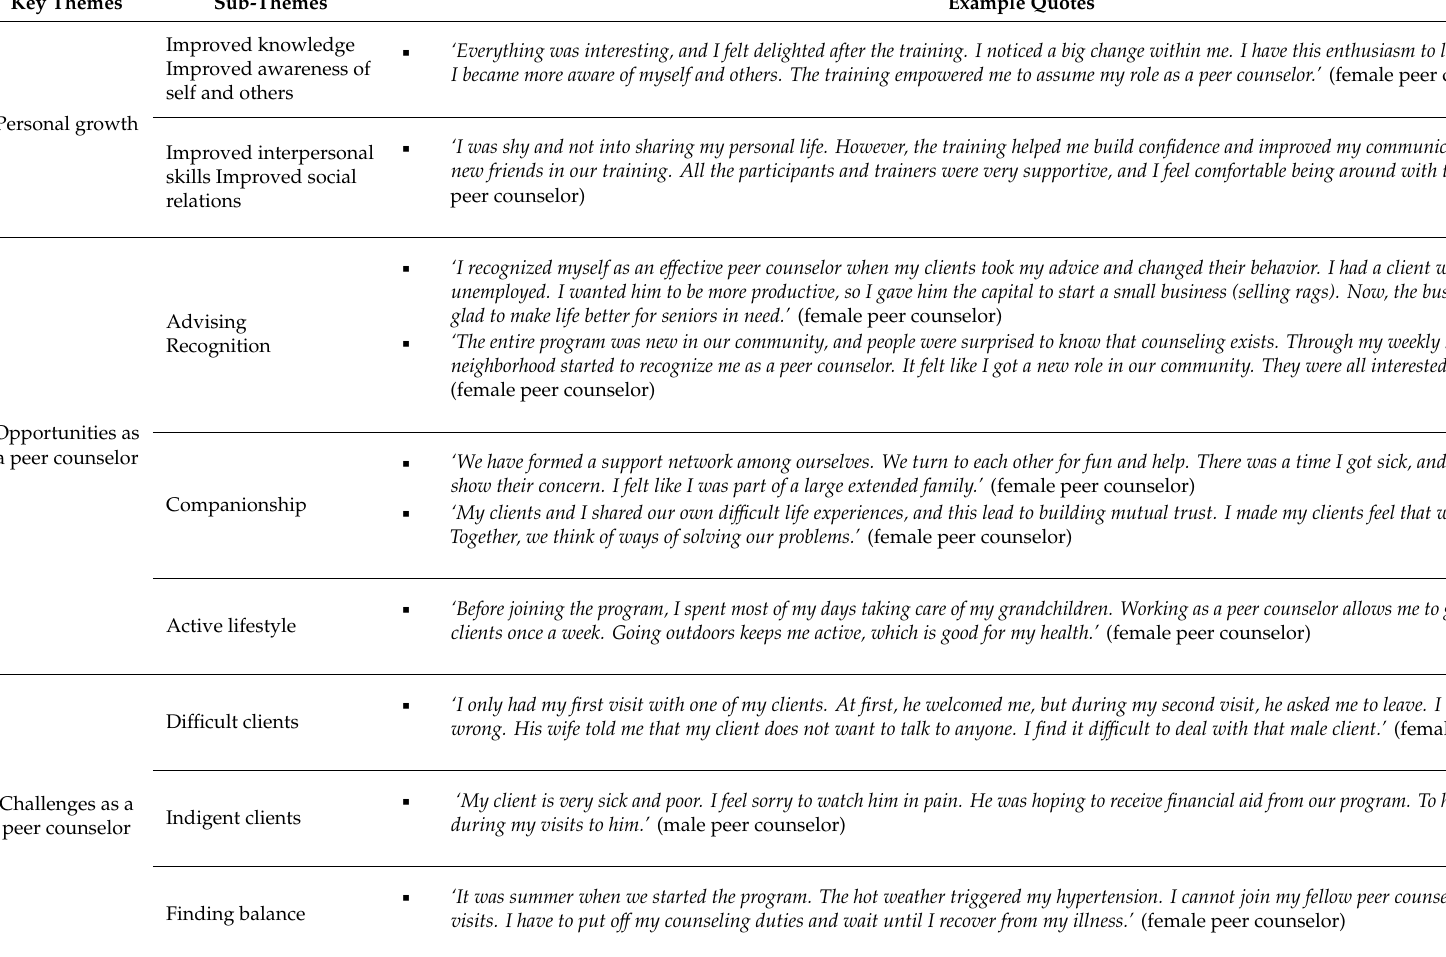
Table 6. Impact of leadership and peer counseling program on peer counselors’ well-being.